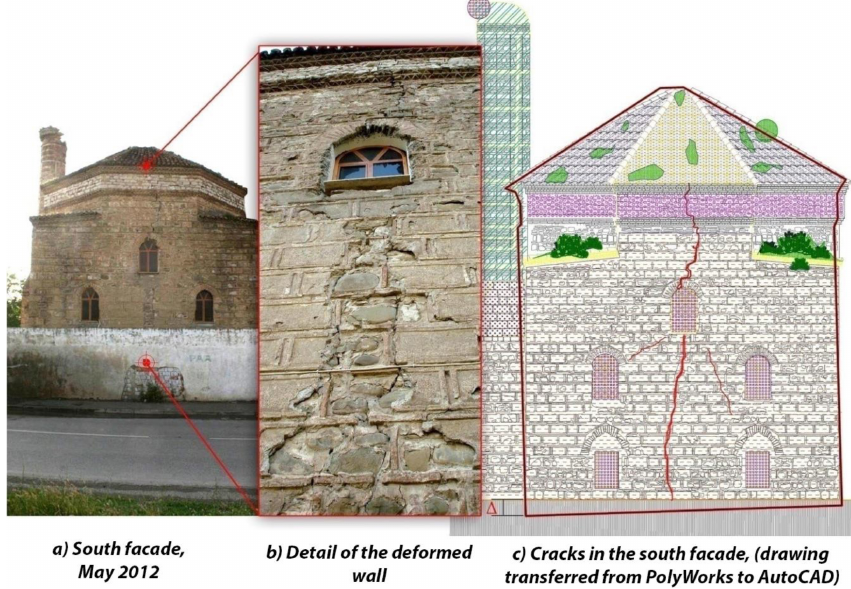
Figure 5. Cracks due to differential settlement ( (cid:49) = 18cm) in the south façade (May